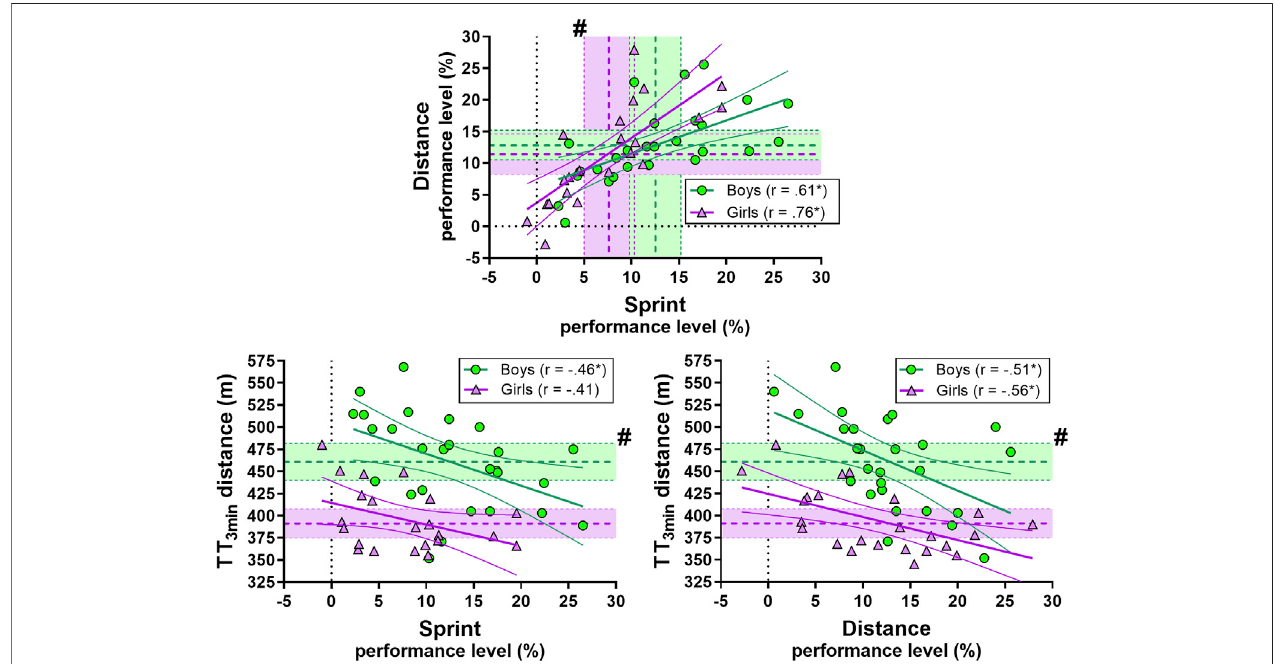
FIGURE 1 | Correlation between sprint and distance performance (upper panel) and sprint and distance performance in TT 3min (lower panel). Green circles represent individual values for the boys. Purple triangles represent individual values for the girls. Shaded areas with dotted lines in the middle represent mean ±95% con fi dence interval (CI). Green is used for the boys and purple for the girls. For distance vs. sprint performance (upper panel) the horizontal shaded area represents mean ±95% for distance performance and the vertical shaded area represents mean ±95% for sprint performance. Thick and narrow lines represent the best fi t regression line and the 95% con fi dence bands (green lines for the boys and purple for the girls). See the method section for an explanation of the performance level. * Correlation is signi fi cant at the 0.05 level. # signi fi cant difference between boys and girls.